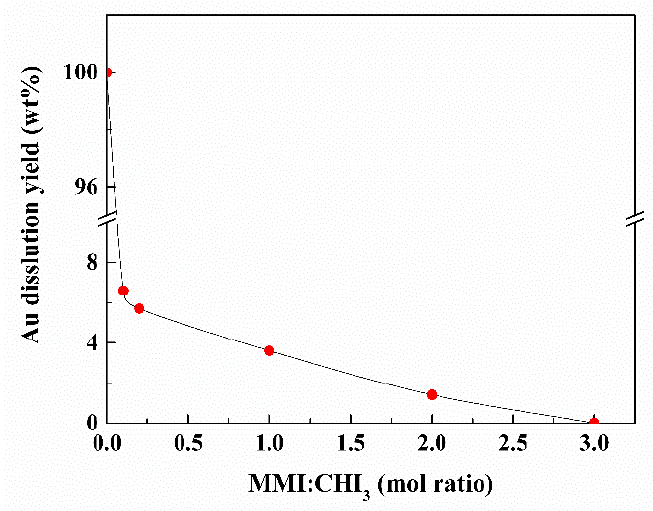
Figure 4. Effect of MMI on leaching yield of gold.